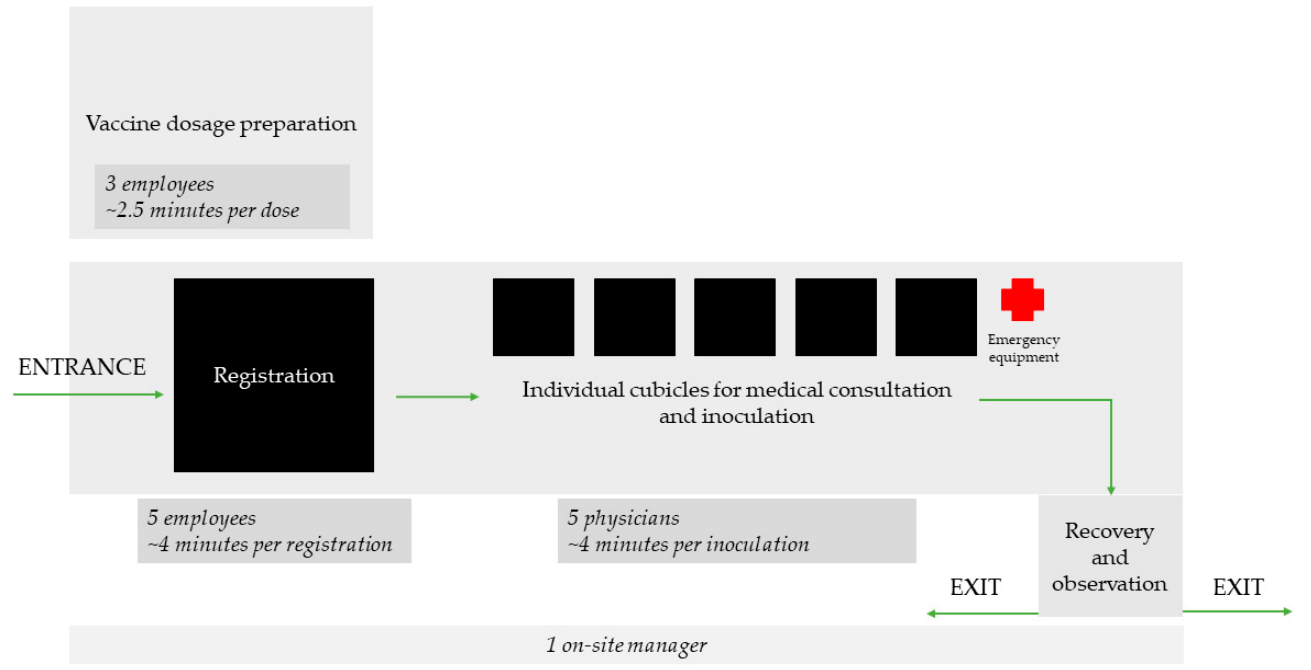
Figure 1. Spatial structure and procedural organisation of the in-hospital vaccination centre of